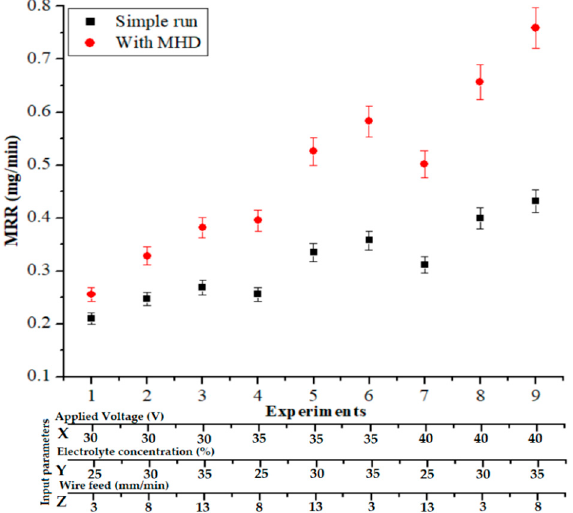
Figure 7. MRR with and without the MHD method being used.